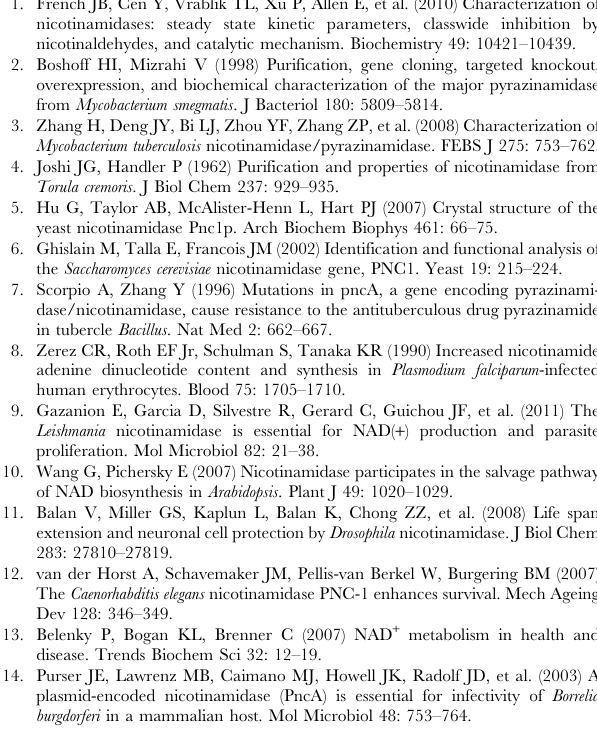
Table S1 Oligonucleotide sequences used for site-di- rected mutagenesis. Table S2 Comparative study of the residues involved in nicotinamidase